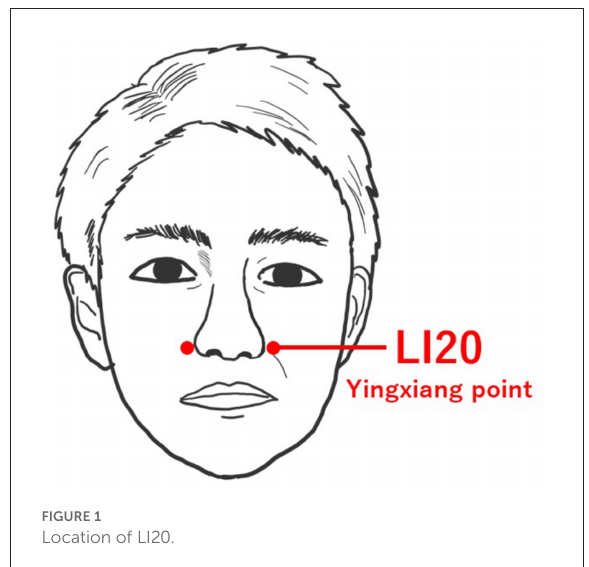
FIGURE1 Location of